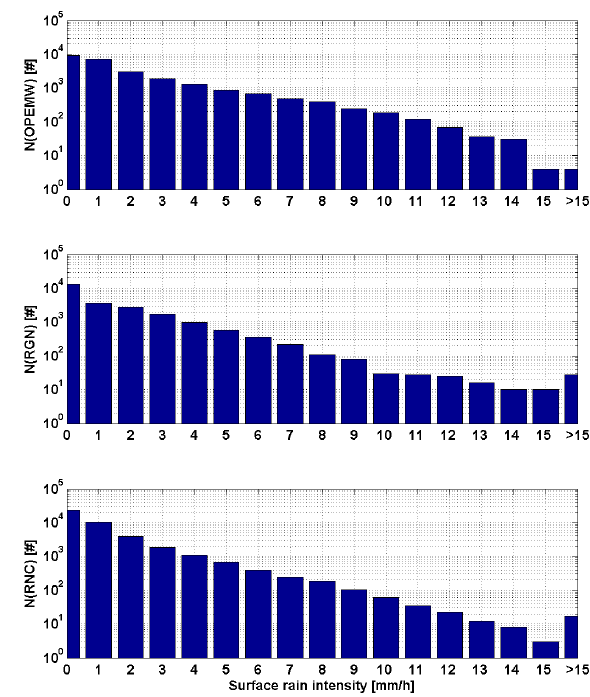
Fig. 4. Histograms of OPEMW (top), RGN (middle), and RNC Figure 4: Histograms of OPEMW (top), RGN (middle), and RNC (bottom) surface rain intensity 3 (bottom) sri products (vertical axis in log scale). Values larger than 15mmh − 1 are grouped in the last bin. (sri) products (vertical axis in log scale). Values larger than 15 mm/h are grouped in the last bin. 4